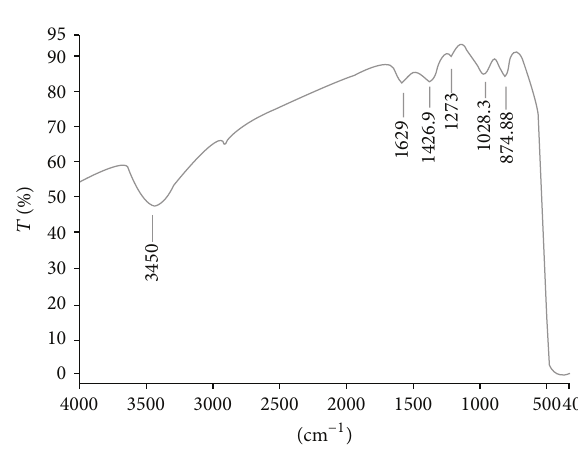
Figure 5: FTIR spectrum of nano-ZnO.